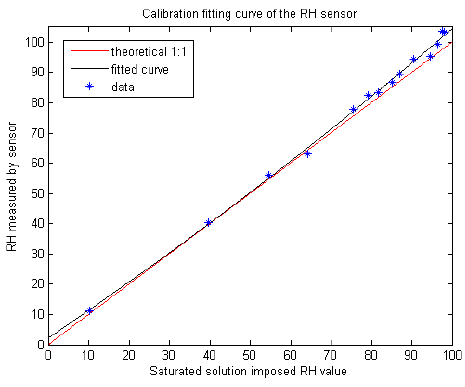
Figure 8. Fitting curve of the calibration model for the RH sensor.